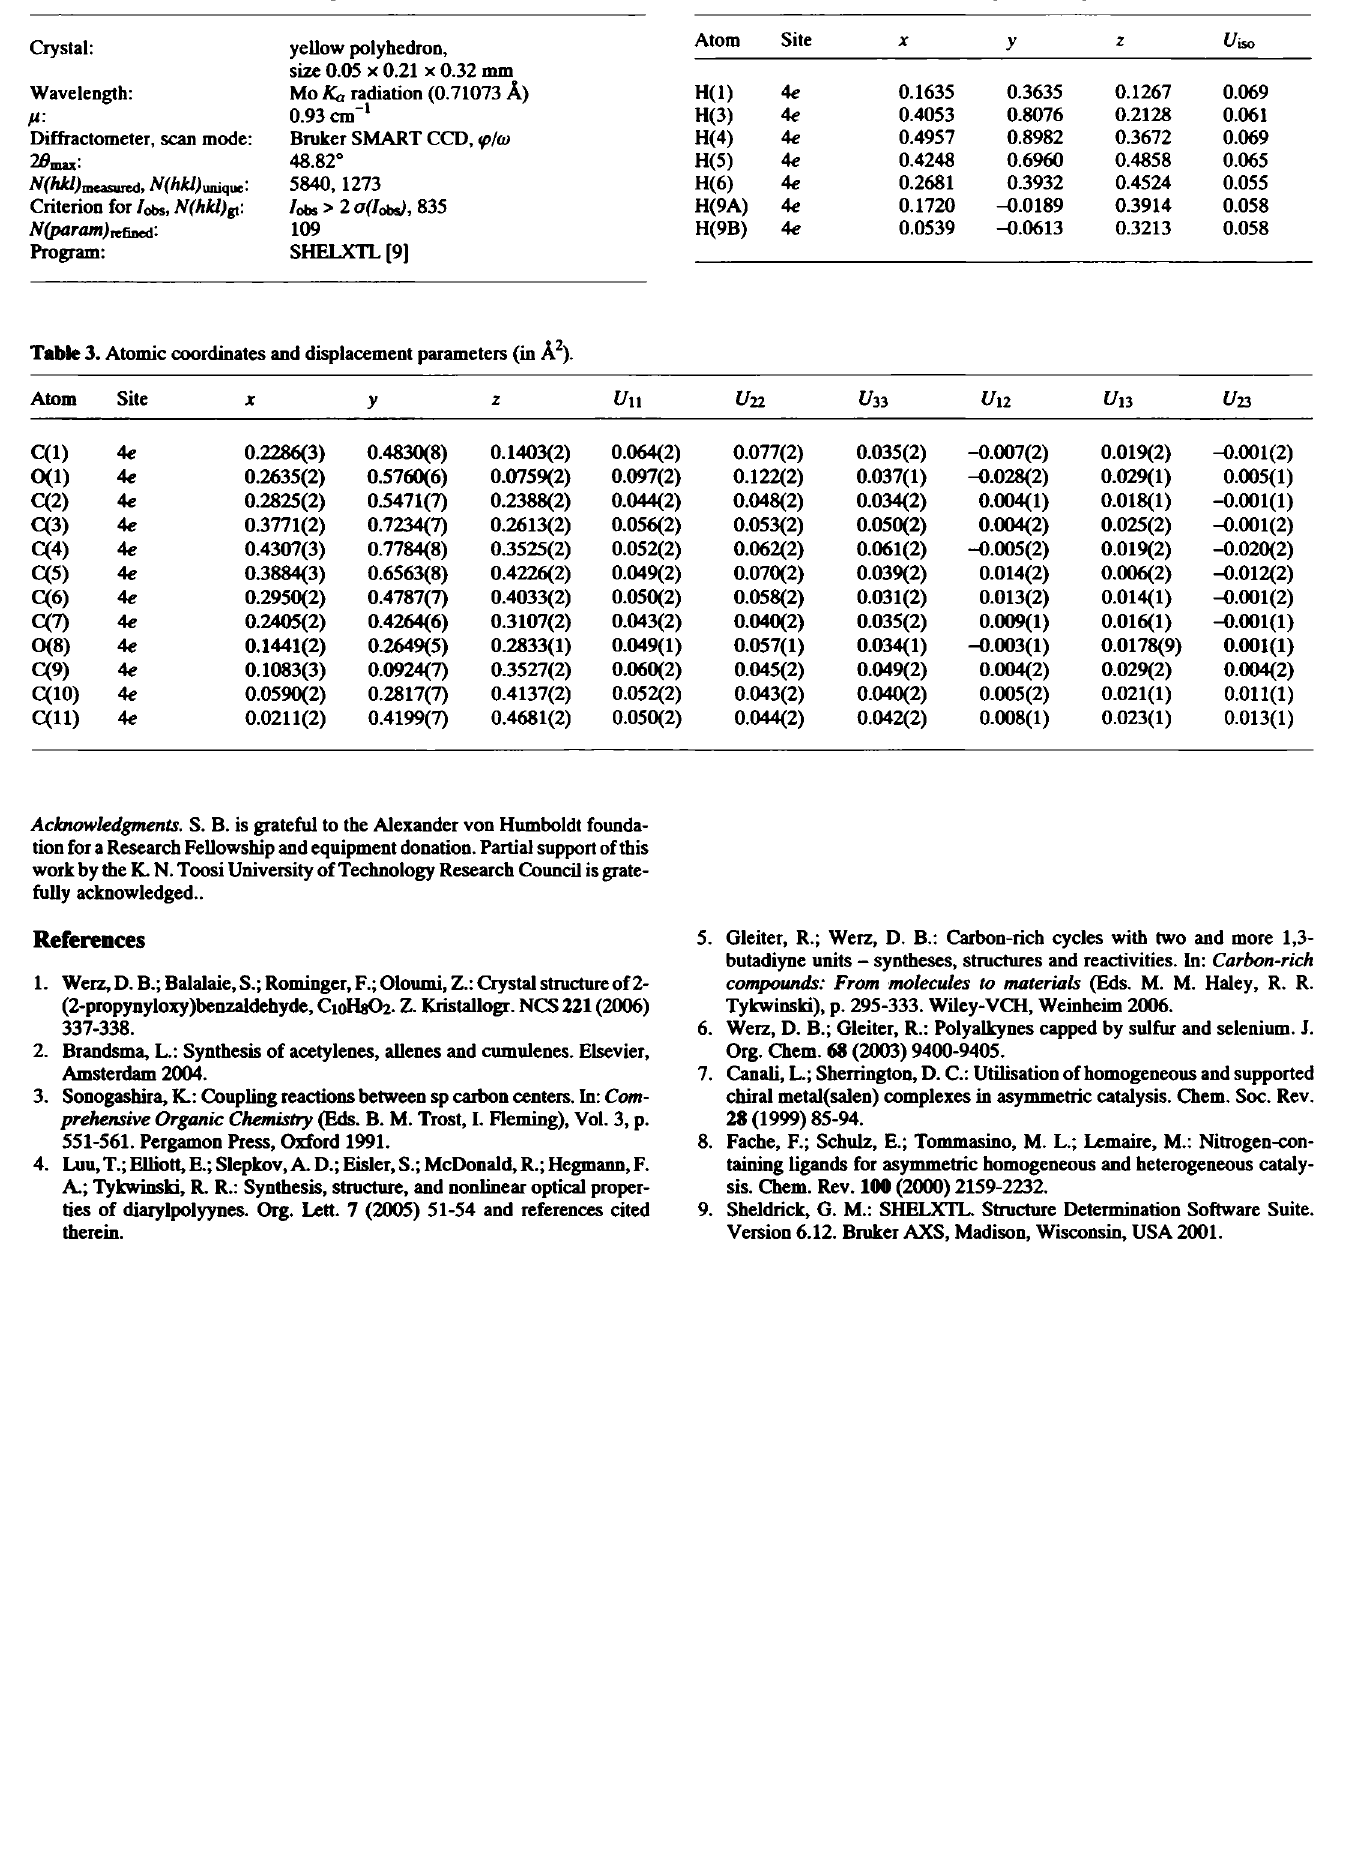
Table 3. Atomic coordinates and displacement parameters (in Ä 2